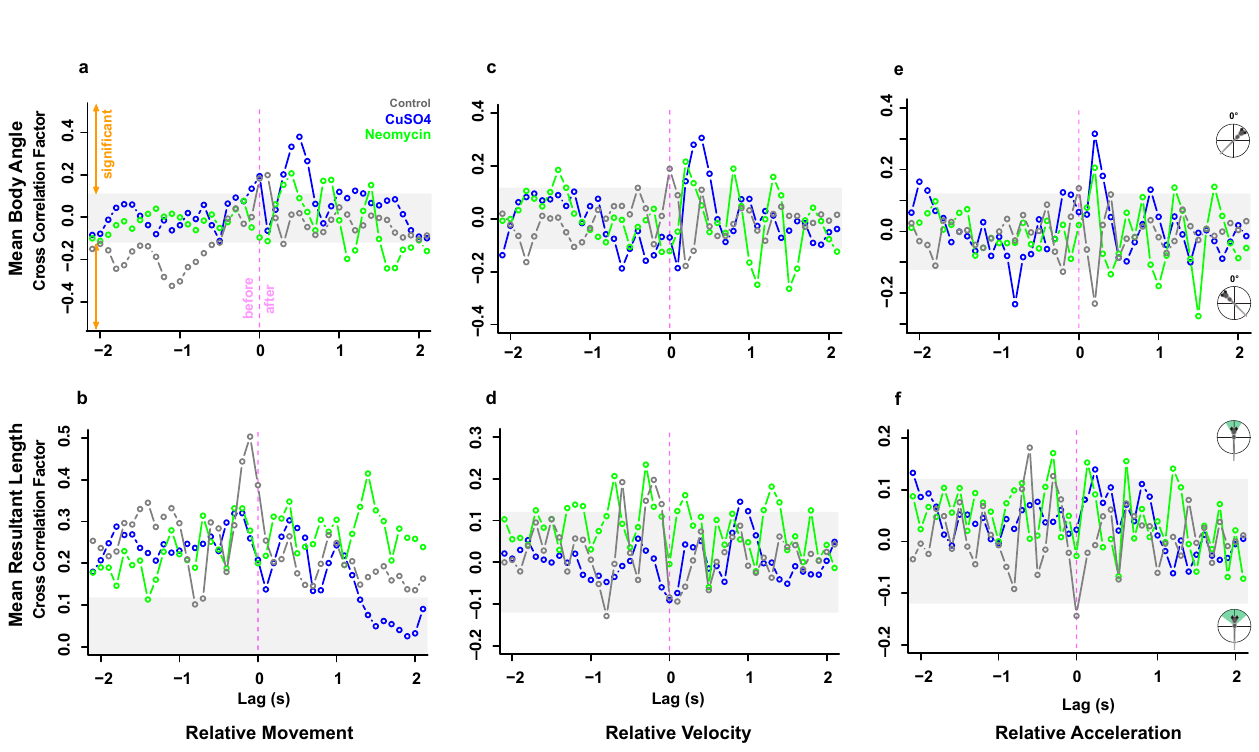
Fig. 9 Cross correlations between linear and angular movement data indicate ototoxic compound-speci fi c changes to the rheotaxis behavioral pro fi le of fi sh. The correlograms depict how an above average increase in relative movement ( a , b ), relative velocity ( c , d ), or relative acceleration ( e , f ) were signi fi cantly cross correlated with above average increases or decreases in the mean body angle ( a , c , e ) or mean resultant length ( b , d , f ). In the fi gures for mean body angle ( a , c , e ), the positive and negative peaks indicate that fi sh were oriented to the right or left of the oncoming fl ow vector, respectively. In the fi gures for mean resultant length ( b , d , f ), the positive and negative peaks indicate fi sh that had a lesser or greater variance of the mean body angle, respectively. The X-axis indicates the relative timing, or lag, of the cross correlation between the angular parameter with respect to an above average increase in the linear parameter (zero = simultaneous occurrence; negative = angular change occurs before linear change; and positive = angular change occurs after linear change). For example, interpret panel 9a as: In control (gray, n = 248) fi sh, above average increases in relative movement are most signi fi cantly correlated with changes in mean body angle to the left of the fl ow vector that previously occurred. In CuSO 4 -treated (blue, n = 204) fi sh, above average increases in relative movement are most signi fi cantly correlated with above average changes in mean body angle that subsequently occurred. In neomycin-treated (green, n = 222) fi sh, above average increases in relative movement are most signi fi cantly correlated with below average changes in mean body angle that subsequently